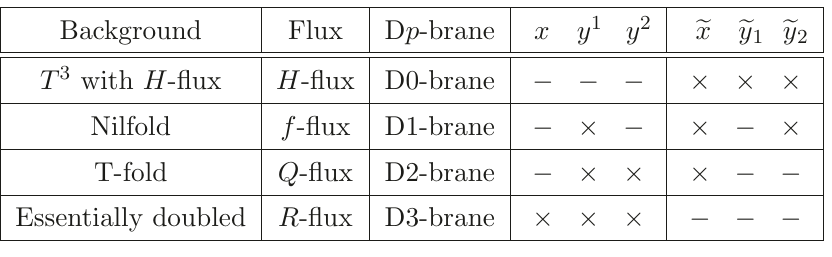
Table 1 . The D p -brane configurations considered in the various T-duality frames of the doubled twisted torus geometry for the case of parabolic monodromies. A dash denotes a normal (Dirichlet) direction to the D-brane, while a cross denotes a worldvolume (Neumann) direction. The number of Dirichlet and Neumann directions in each case are both equal to